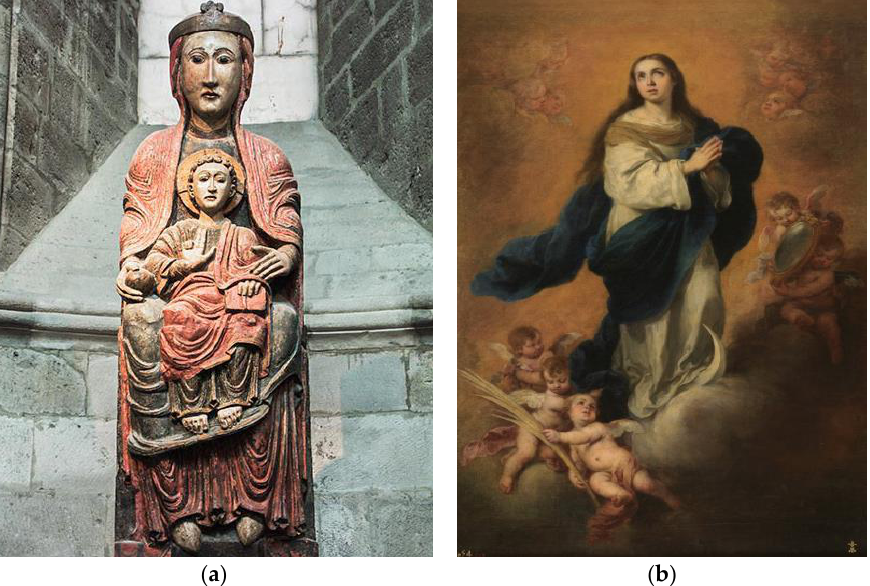
Figure A1. ( a ). María entronizada, Thirteenth century, Catedral de Tudela (Navarra, Spain) ( left ) ; ( b ) Bartolomé Esteban Murillo, “La Inmaculada Concepción,” 1665– 1675, Museo Del Prado (Madrid, Spain) ( right ). (2) Mary and Child’s gazes and intimacy .